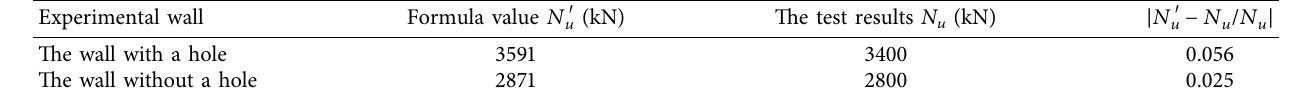
Table 3: The comparison between the calculated results and the experimental results. Experimental wall